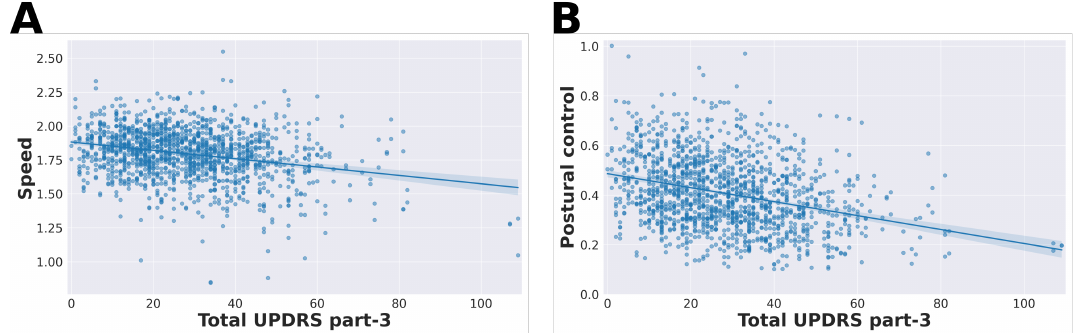
Figure 6. Correlation of feature values with total UPDRS part-III scores. Most features were significantly correlated with total UPDRS part-III scores (Table 2). ( A ) Estimated step frequency (speed) was significantly correlated with total UPDRS part-III scores (Pearson’s r = − 0.26, p < 0.001). ( B ) Postural control feature values were significantly correlated with total UPDRS part-III scores (Pearson’s r = − 0.31, p <